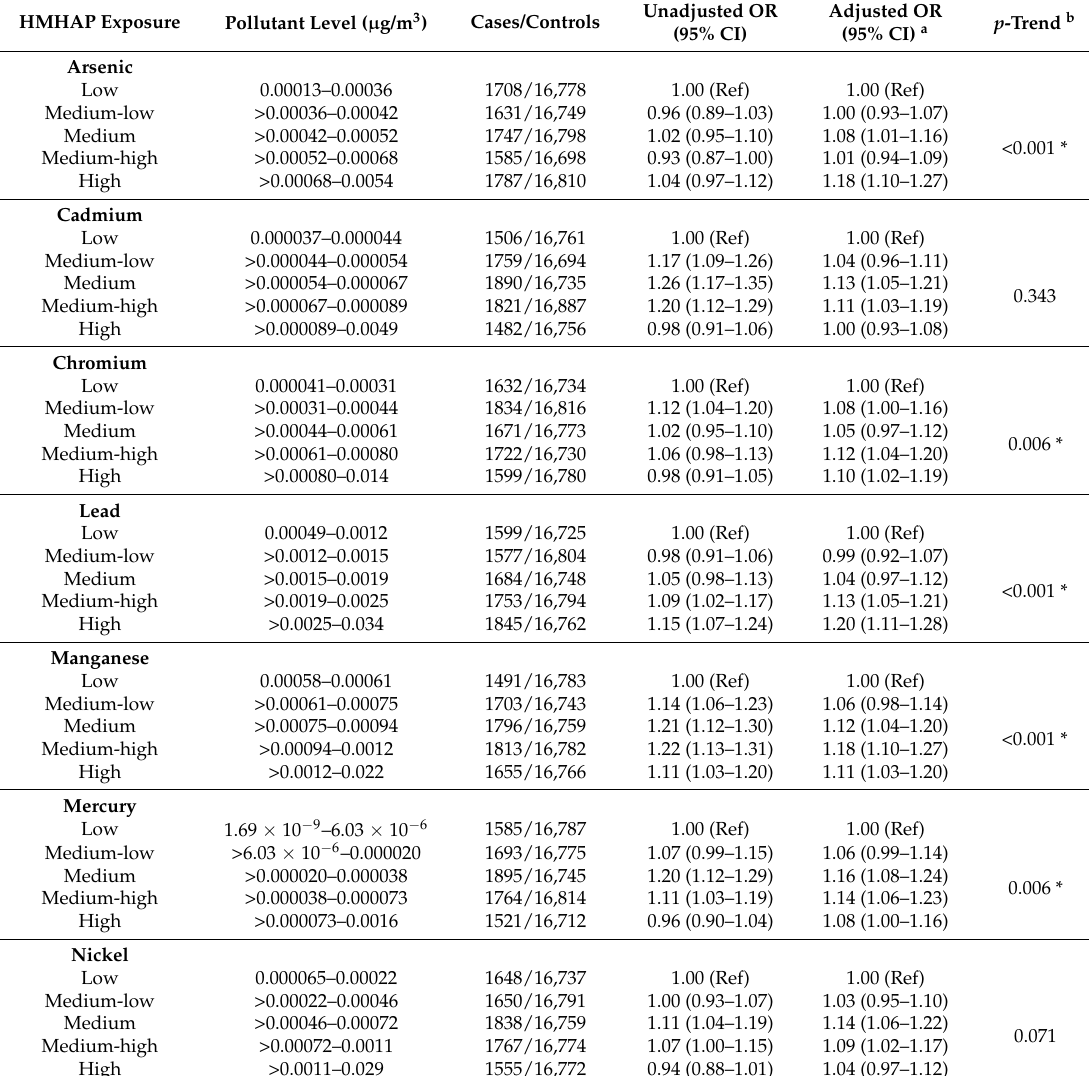
Table 2. Unadjusted and Adjusted Odds Ratio (95% CIs) for associations between HMHAPs and